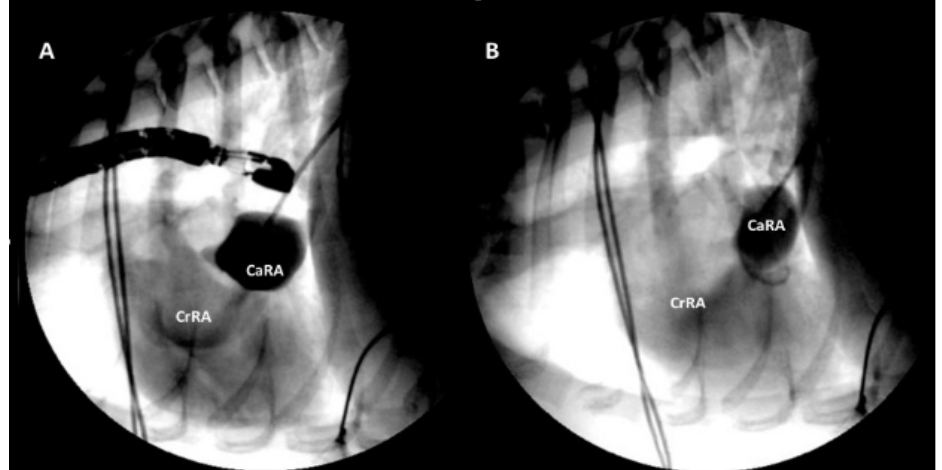
Figure 3. Lateral angiographic images of case 1 after contrast injection in the caudal vena cava pre- dilation ( A ) and post-dilation ( B ) showing increased size of the membrane perforation and increased flow from the caudal right atrial chamber to the cranial right atrial chamber.